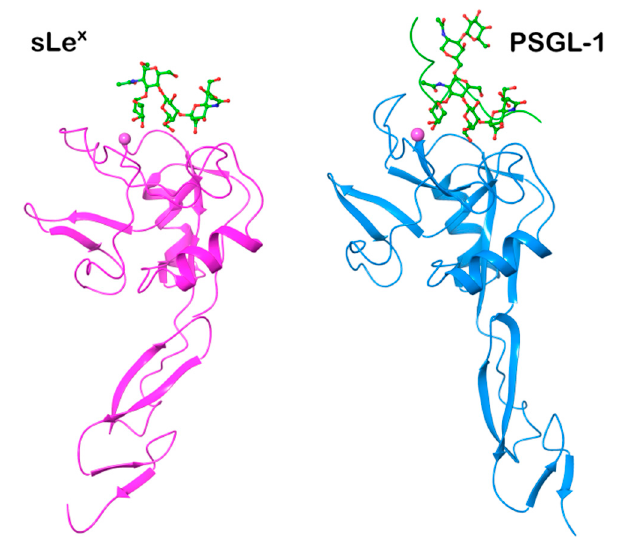
Figure 3. Comparison of the 3D structures of P-selectin complexed with sLe x (purple, PDB 1g1r) representing the bend conformation and PSGL-1(blue, PDB 1g1s) that represents the extended, high-affinity conformation [36].